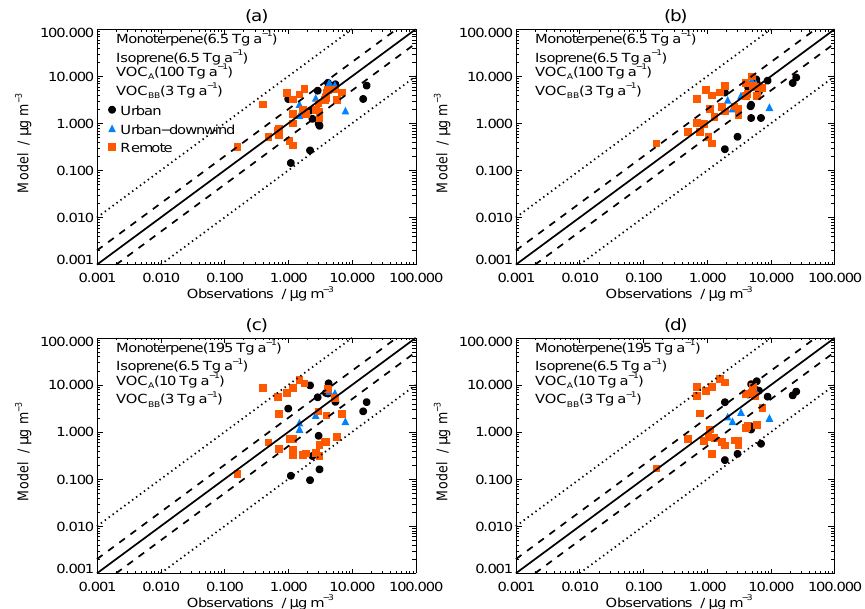
Fig. 8. As for Fig. 3 for (a) OOA and (b) OA with our best estimate SOA sources (simulation 33) and (c) OOA and (d) OA with best estimate sources but restricted anthropogenic SOA (simulation